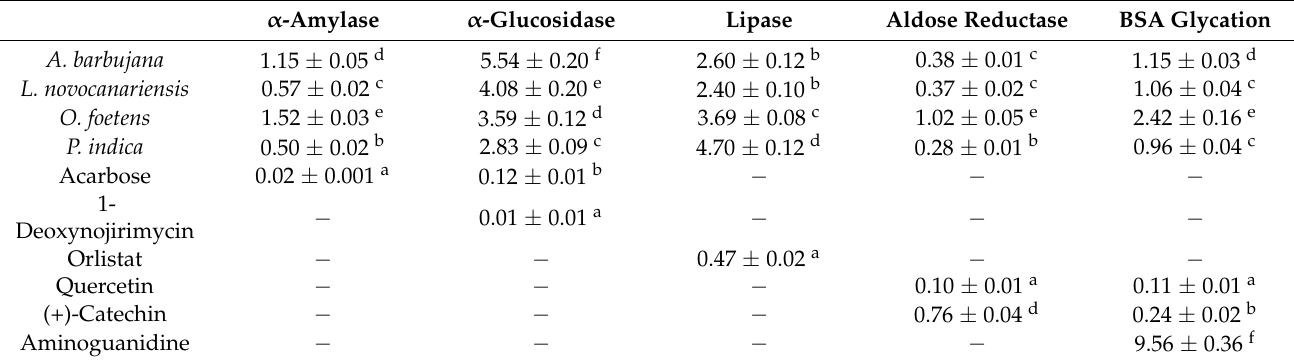
Table 2. In vitro inhibitory activities of Lauraceae leaf extracts towards carbohydrate-hydrolyzing enzymes, pancreatic lipase, aldose reductase and BSA-glycation. Results are expressed as the IC 50 value (mg mL − 1 of dry extract or pure compound). Acarbose, 1-Deoxynojirimycin, Orlistat, Quercetin, (+)-Catechin and Aminoguanidine were used as positive controls for α -amylase, α -glucosidase, lipase, and aldose reductase and BSA glycation assays, respectively. α -Amylase α -Glucosidase Lipase Aldose Reductase BSA